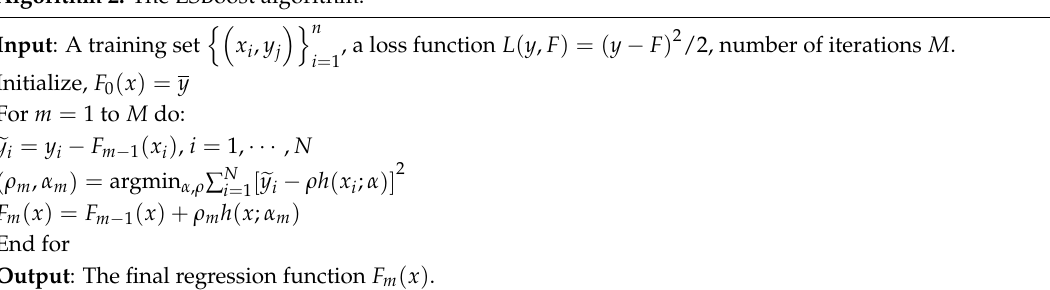
Algorithm 2. The LSBoost algorithm.